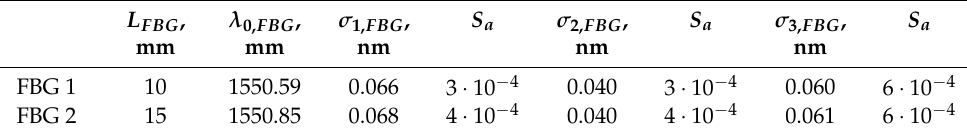
Table 1. Coefficients of approximation of FBG